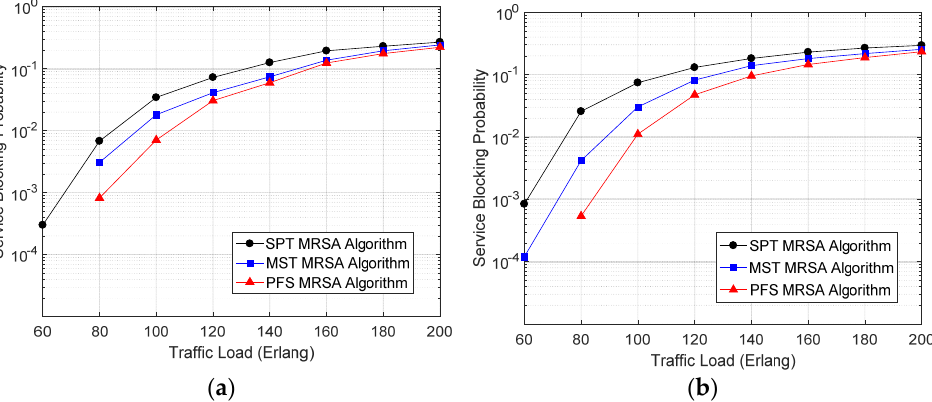
Figure 7. Simulation results on service blocking probability in different network architectures under scenario three: ( a ) in NSFNET and ( b ) in USNET.